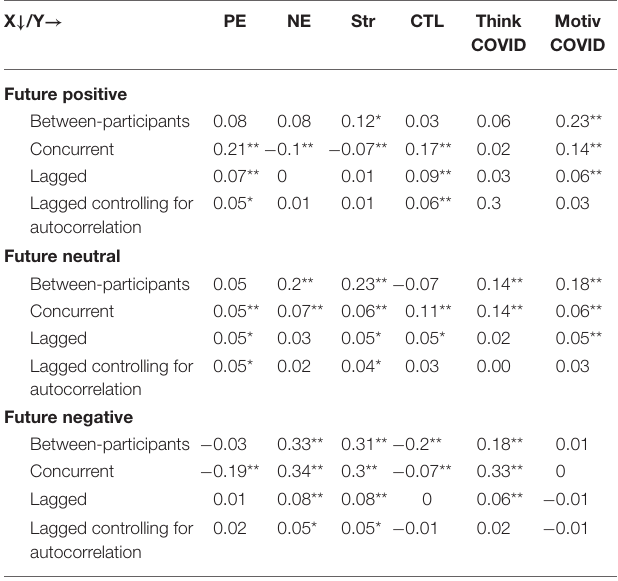
TABLE 3 | Multilevel models of relationship between future thinking and emotional responses during daily diary